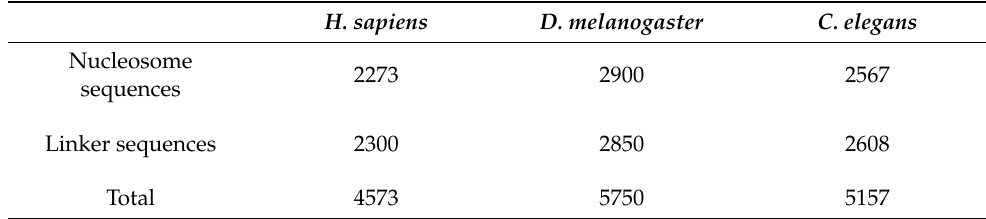
Table 1. The number of positive samples and negative samples in the DatasetNup_1